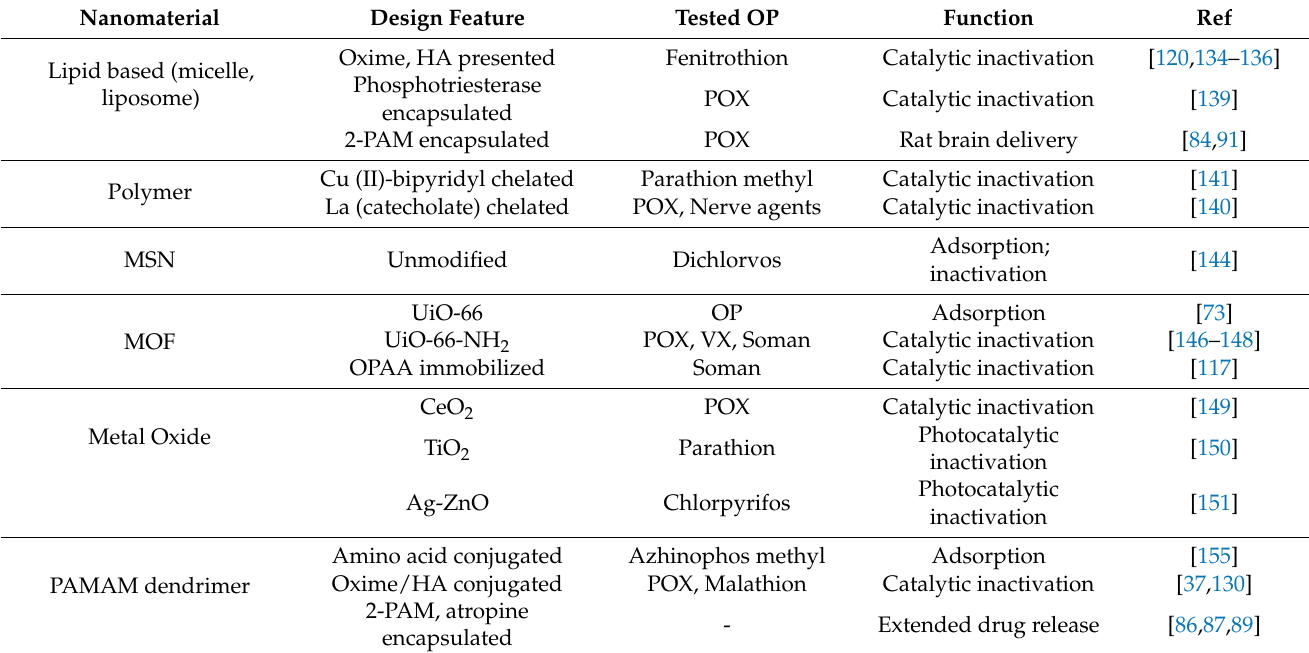
Table 2. Nanomaterial-based therapeutic platforms for applications in antidote drug delivery or reactive organophosphate (OP)